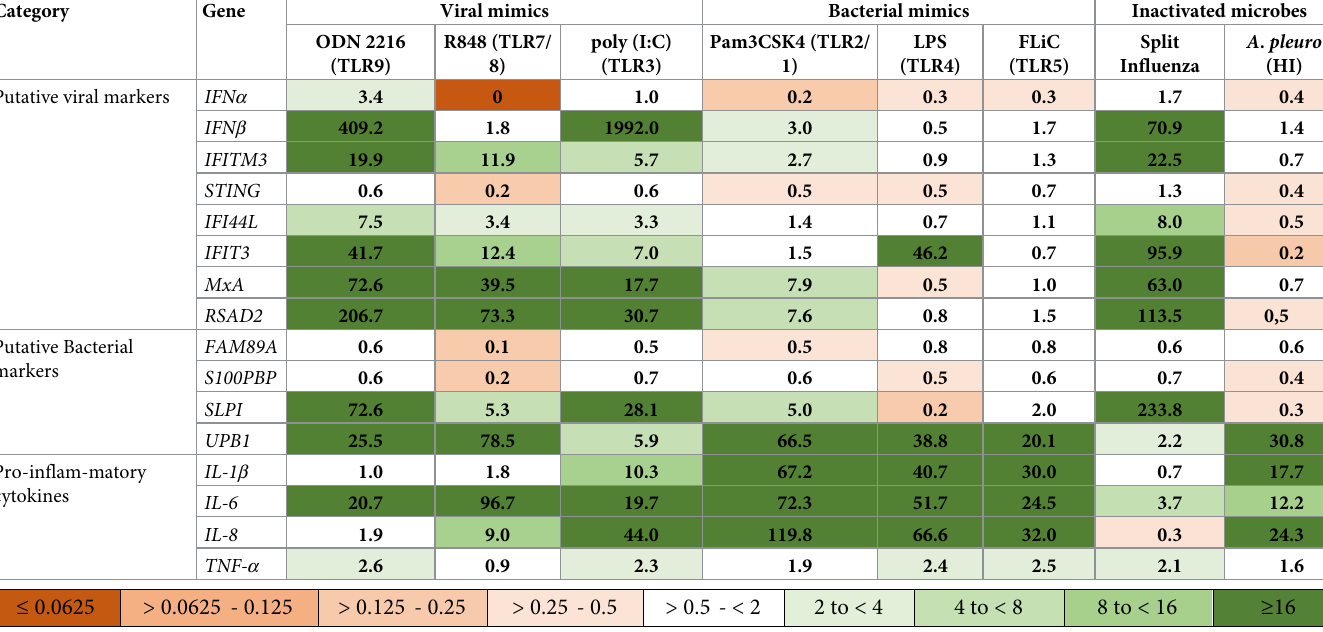
Table 2. Heat map illustrating gene expression patterns in porcine PBMC, exposed in vitro to ODN 2216, R848, poly (I:C), Pam3CSK4, FliC, LPS, split influenza virion or heat-inactivated A . pleuropneumoniae for 18h. Category Gene Viral mimics